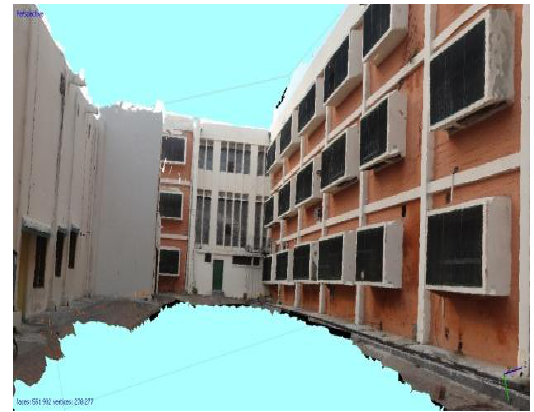
Figure 15: Textured 3D model of one portion of building at